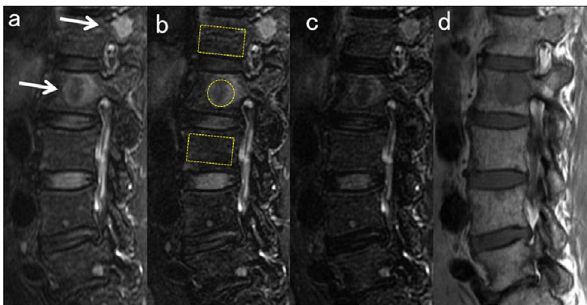
Figure 4. Sagittal MRI in a 65-year-old man with combined focal and diffuse infiltration pattern (BMPC%, 71%). a ) Water image of IDEAL; b ) FS-T 2 FSE; c ) STIR; d ) T 1 FSE; and e ) CT. ROIs of lesion and background BM used for the percent contrast computation are demarcated in the images. The actual ROIs of BM are placed in similar locations in the midsagittal images. The focal myeloma lesion in L4 is seen as a slightly high intensity signal on fat-suppressed images (white arrows) but is less conspicuous compared to the lesion in Figure 3. Among the three fat-suppressed images, signal hyperintensity of the lesion is less conspicuous in STIR (c) than in water image of IDEAL (a) or FS- T 2 FSE (b). The focal lesion is not detected on T 1 FSE (d).